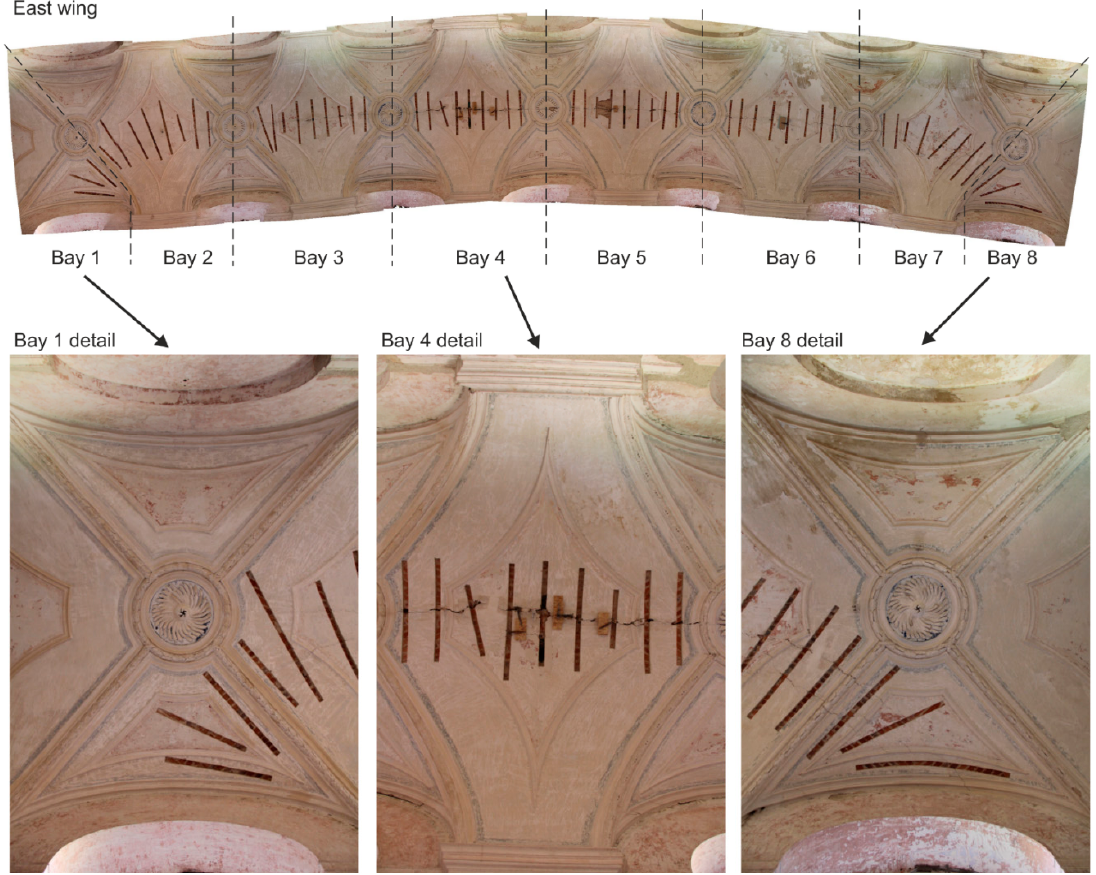
Figure 7. Carbon strips arrangement on the soffit of the arcaded walk’s vault.